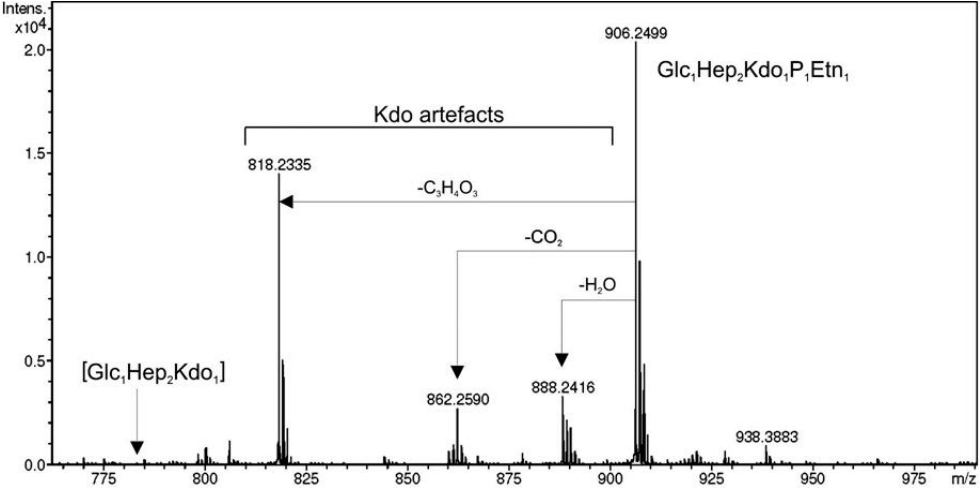
Figure 5. High-resolution electrospray ionization mass spectrum of core OS obtained by mild acid hydrolysis from LPS isolated from K. pneumoniae 52145∆ wabG harboring plasmid pBAD18-Cm- eptC